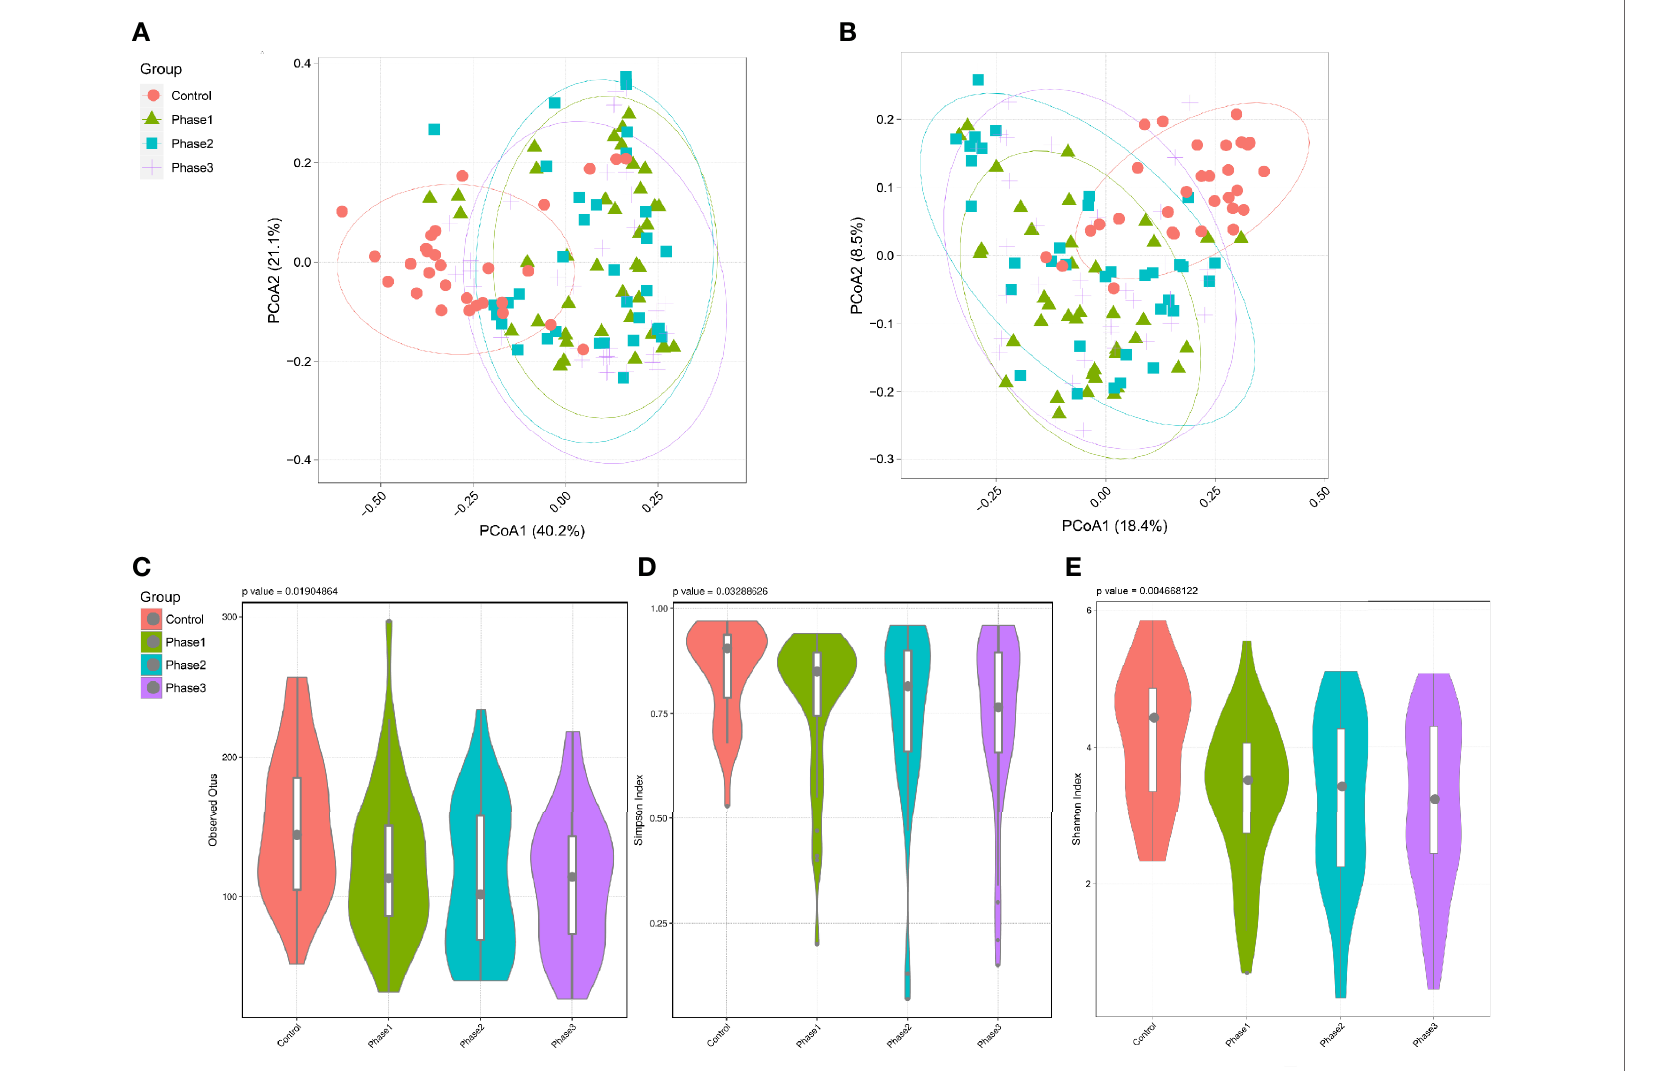
FIGURE 2 | Diversity analysis of the gut microbiota of the HBV-ACLF patients. (A) PCoA plot based on weighted unifrac distance of the three phases of HBV-ACLF and the HC group (permutation test, p = 0.001). (B) PCoA plot based on unweighted unifrac distance of the three phases of HBV-ACLF and the HC group (permutation test, p = 0.001). (C) Operational taxonomic units (OTUs) of the three phases of HBV-ACLF and the HC group. P = 0.019 from t test. (D) Simpson index of the three phases of HBV-ACLF and the HC group (p = 0.033 from t test). (E) Shannon index indicated the community diversity of the three phases of HBV-ACLF and HC group (p = 0.0046 from t